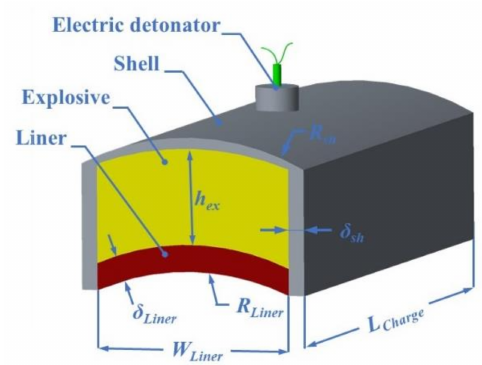
Figure 1. Schematic diagram of a linear-shaped charge (LSC).